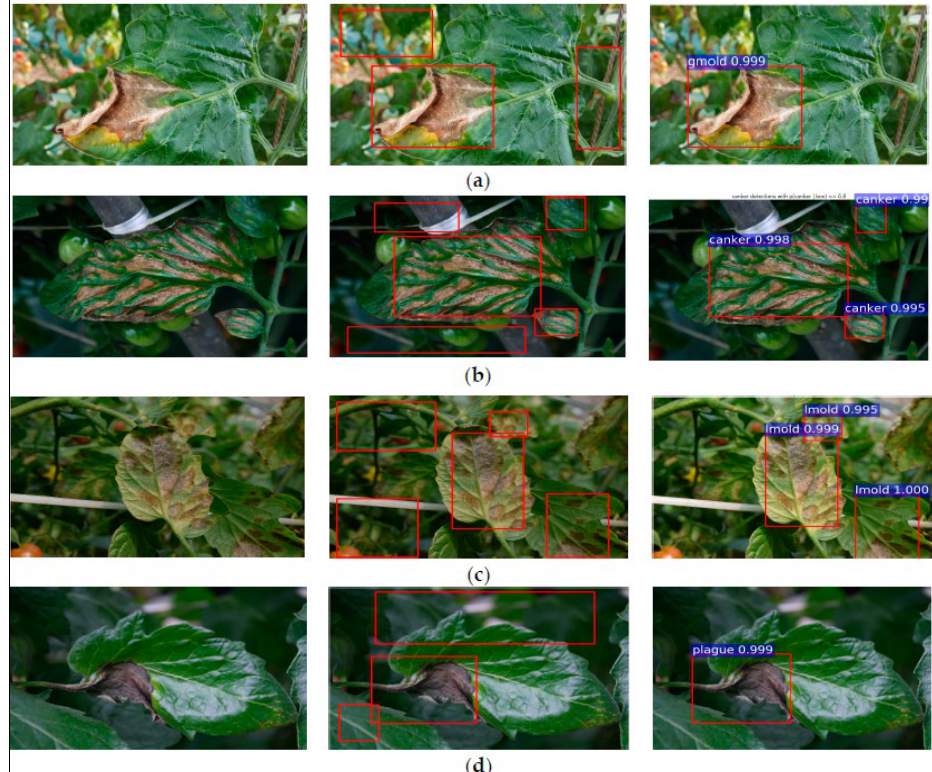
Figure 4. Detection result of disease and pests that affected tomato plants. ( a ) Gray mold ( b ) Canker ( c ) Leaf mold ( d ) Plague [109].